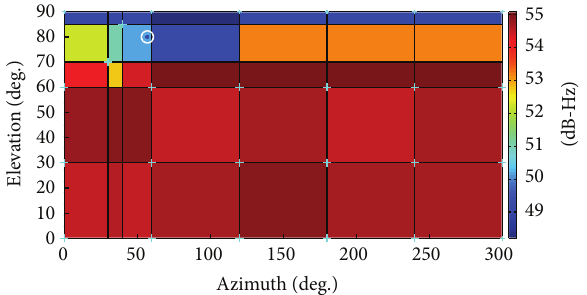
Figure 5: Changing interference incident angle—variation of 𝐶/𝑁 0